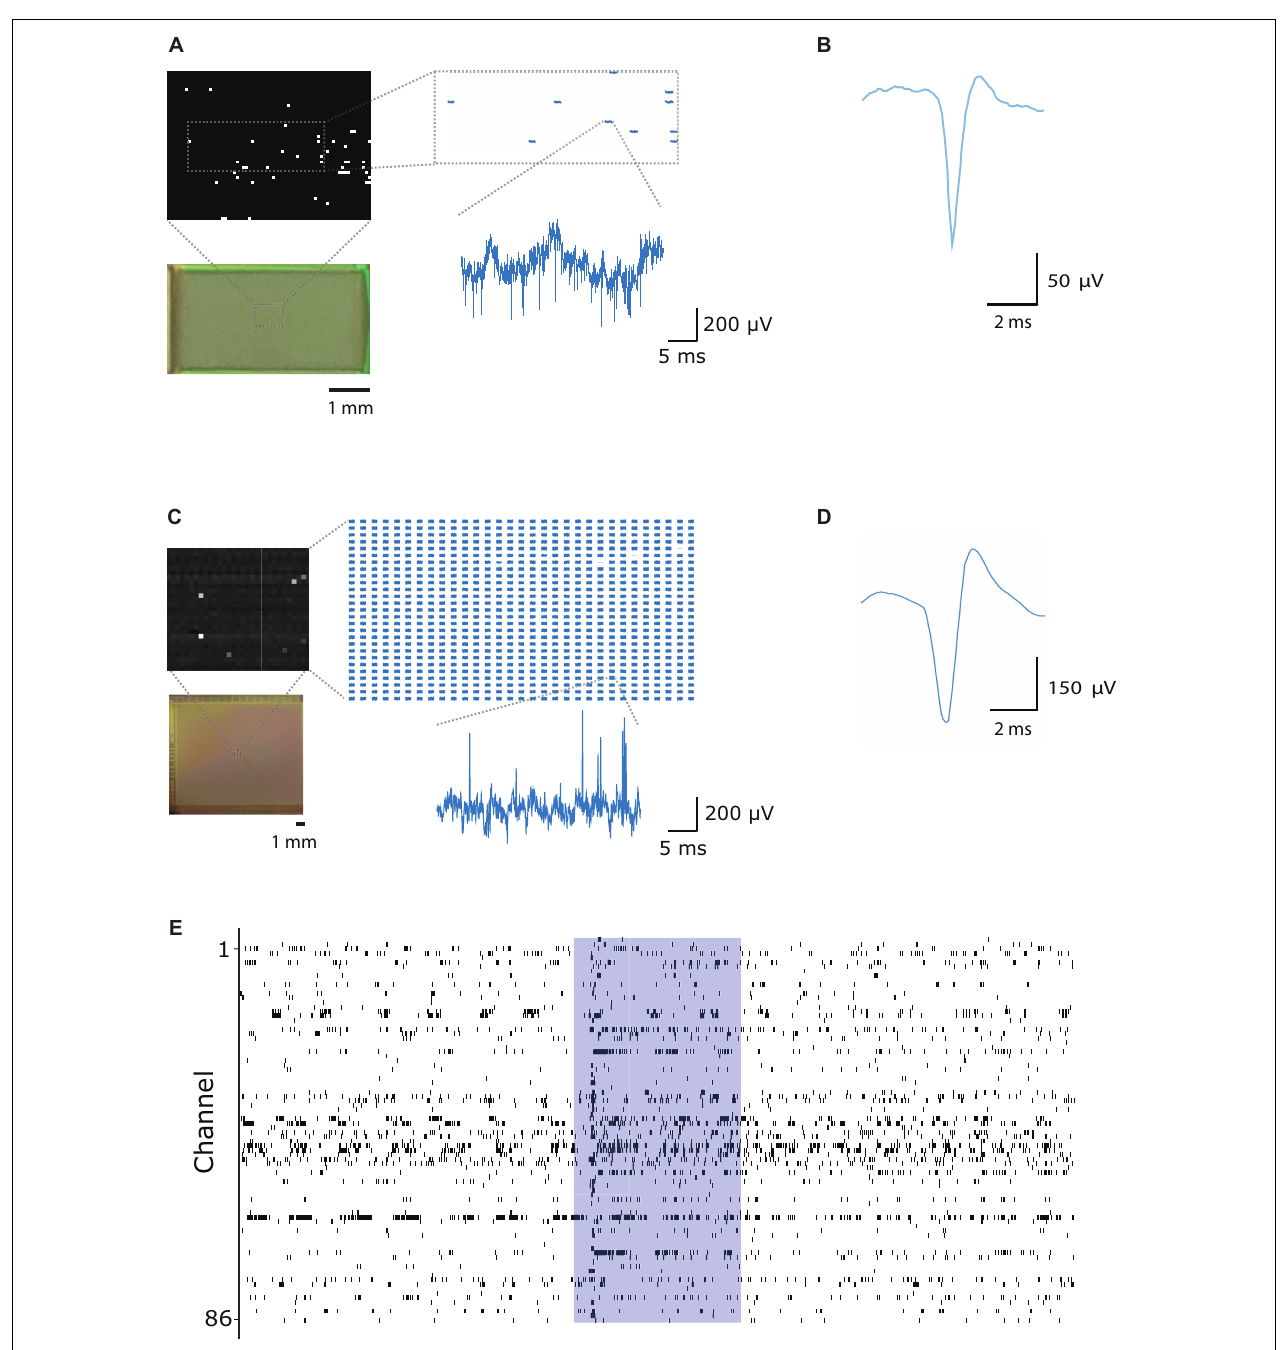
FIGURE 6 | Large-scale, parallel electrophysiological recordings with CHIME. (A) Switch-matrix based MEA chips allow for recording selectively from the pixels connected to electrodes. The inset shows traces recorded within the frame. Only pixels connected to electrodes are pre-selected and recorded. Voltage trace scale bars: 5 ms and 200 µ V. (B) Average spike waveform recorded from the mouse main olfactory bulb with the switch-matrix MEA chip (Müller et al., 2015). (C) CMOS IR camera chips (Neys et al., 2008) provide a frame stream from a large number of pixels. All pixels are recorded in a pre-selected rectangular region, of which only a subset is connected to electrodes. Scale bars: 5 ms and 200 µ V. (D) Average spike waveform recorded from the mouse main olfactory bulb with the IR camera chip. (E) Spike events recorded from 86 channels in the mouse main olfactory bulb with the Mea1k CMOS. The blue area indicates the timing of a 1 s long odor stimulus.